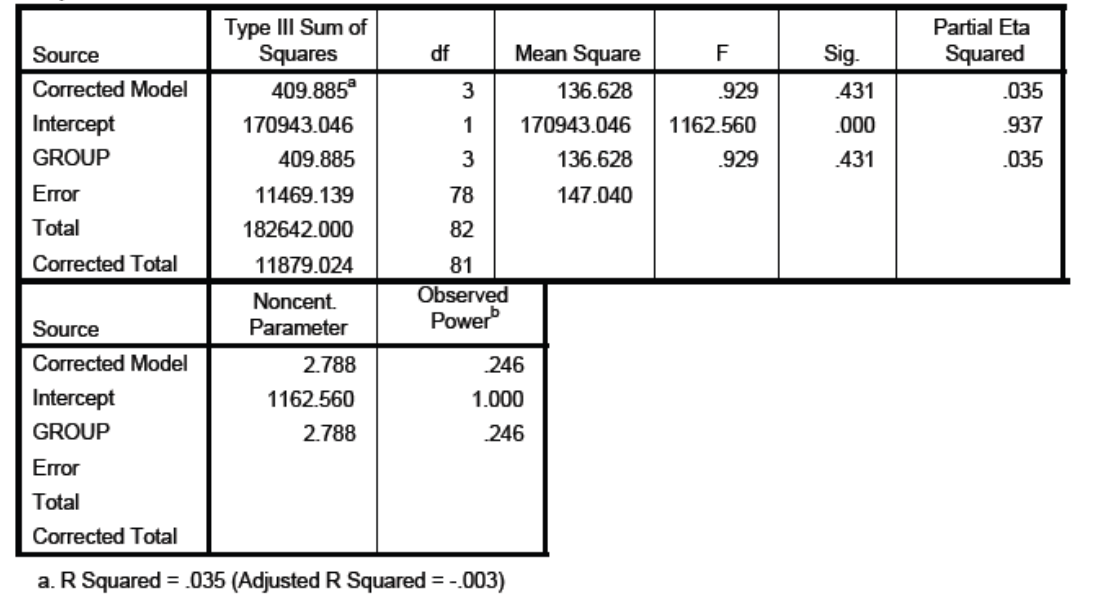
Figure B.2. ANOVA analysing engagement levels between the four groups of participants using raw